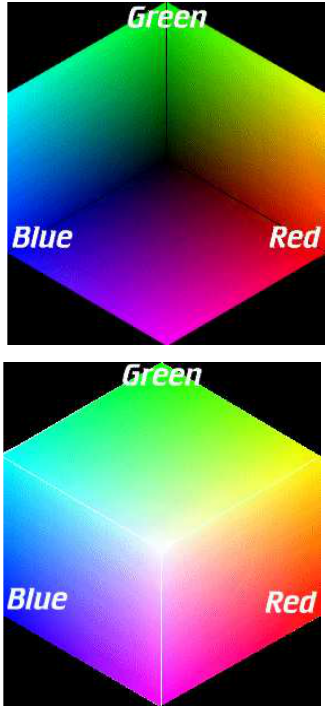
Fig. 2. Representation of the RGB colour model 2 . On the RGB cube in figure 2 2 we see that colours lying close to black are ‘dark’ colours while colours lying close to white are ‘light’ colours. Inspired by this observation we will sort the colours in RGB from ‘dark’ colours to ‘light’ colours, with respect to their distance to the centre m = (1 / 2 , 1 / 2 , 1 / 2) of the RGB cube (as the middle of the black and white